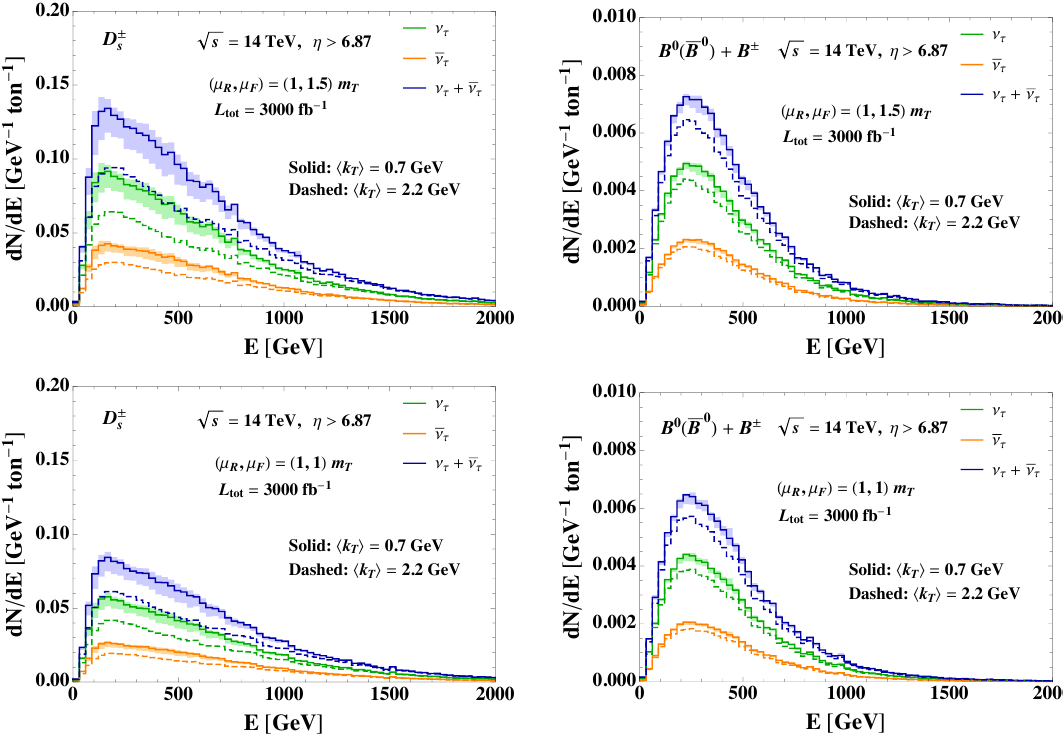
� [ ��� ] Figure 5 . Our predictions for the tau neutrino and/or antineutrino number of charged-current events per GeV per ton as a function of the incident neutrino energy for neutrino pseudorapid- p ity (cid:17) > 6 : 87 for pp collisions with s = 14 TeV and integrated luminosity L = 3000 fb (cid:0) 1 . The central predictions (solid histogram) refer to the h k T i = 0 : 7 GeV value and the bands arise from the h k T i variation in the range 0 < h k T i < 1 : 4 GeV. The results obtained with h k T i = 2 : 2 GeV are also shown (dashed histogram). The upper plots are obtained by setting the QCD scales to ( (cid:22) R ; (cid:22) F ) = (1 : 0 ; 1 : 5) m T , while the lower plots refer to the conventional scale combination ( (cid:22) R ; (cid:22) F ) = (1 : 0 ; 1 : 0) m T . NLO corrections are included in the DIS cross sections.